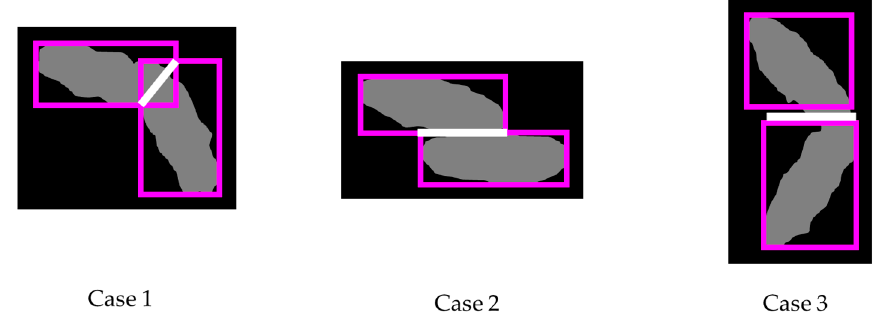
Figure 8. Segmentation with two useful BBs.